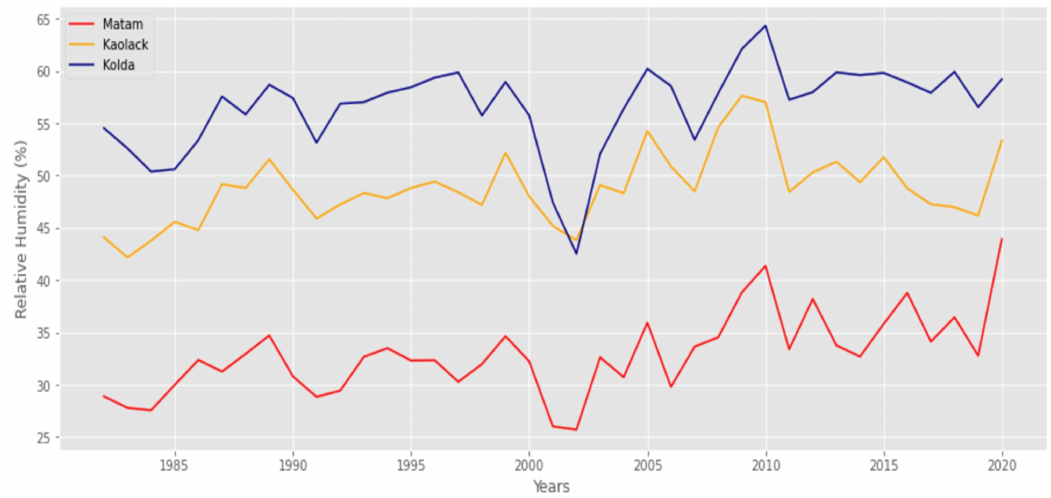
Figure 6. Annual average Relative Humidity for Matam, Kaolack and Kolda